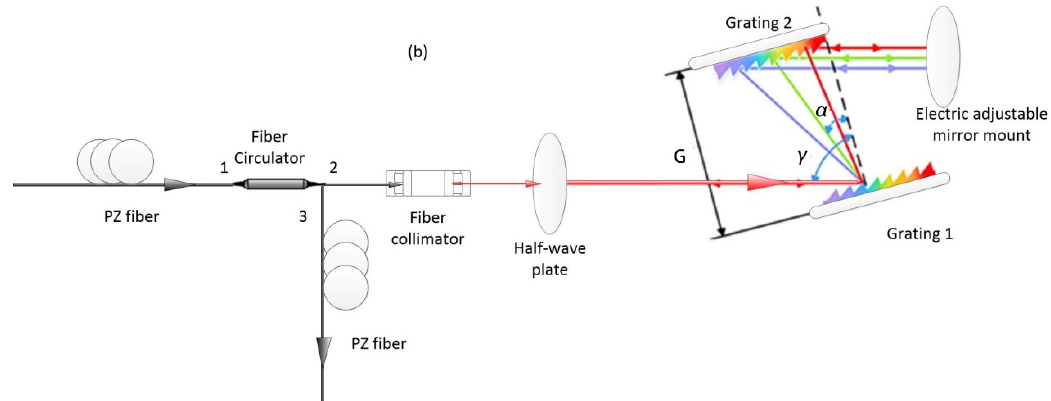
Figure 3. Diagram of compensation device ( a ) photograph; ( b ) schematic.